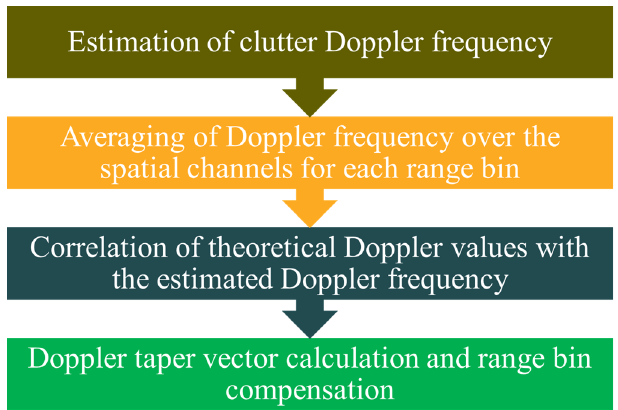
Figure 7. Proposed adaptive Doppler compensation method.